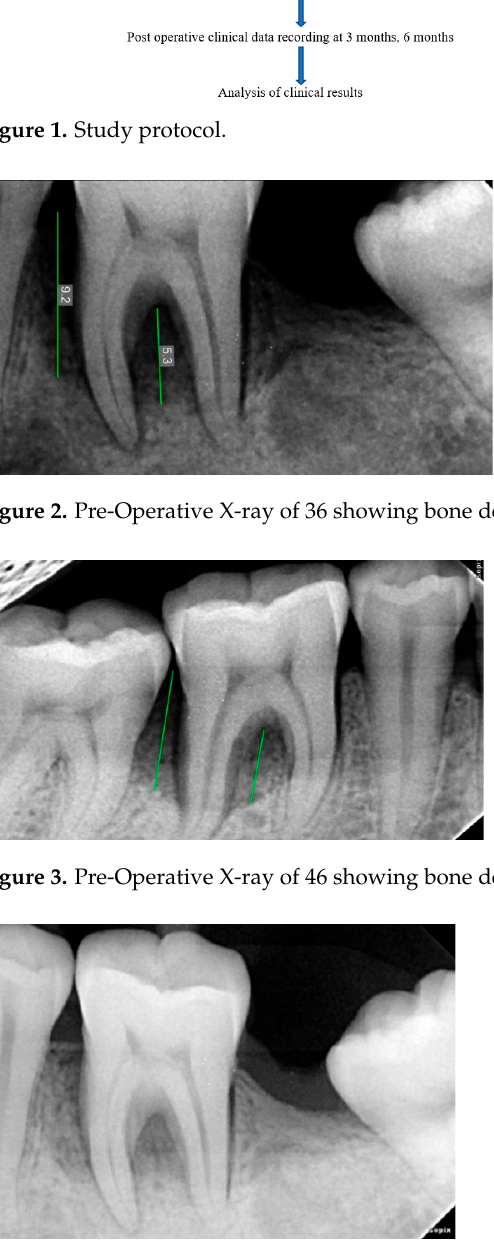
Figure 5. Six Month Post-Operative Radiograph of 36 treated with AM + NB. Figure 6. Three Months Post-Operative Radiograph of 46 treated with BM + NB. 2.4. Surgical Procedure Following Phase I therapy, the patients were reevaluated to confirm the inclusion criteria. Extraoral and intraoral areas were disinfected with 5% povidone iodine and 0.2% chlorhexidine mouthwash, respectively. The interdental papilla was retained while a full- thickness mucoperiosteal flap was reflected after the surgical site had been anesthetized with 2% Xylocaine HCl and adrenaline (1:80,000). After flap reflection and exposure of the osseous defect, a thorough debridement was done followed by irrigation with Normal saline. Defect depth was measured from the bottom of the defect to the clinically visible cemento-enamel junction using William’s probe and graft placed after pre-suturing. Randomly selected intrabony defect sites were covered with the AmnioGuard [7–9] and BioMesh membranes, respectively. Both membranes were selectively trimmed ac- cording to the defect area and placed. Interrupted sutures were placed to obtain the pri-